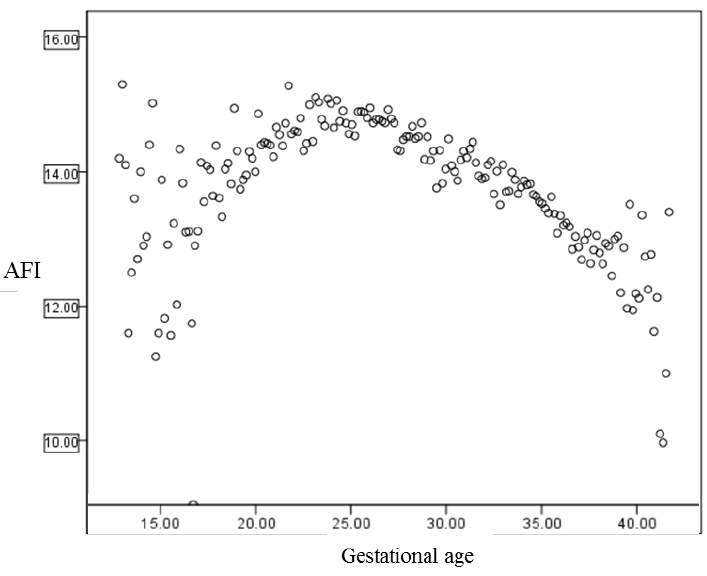
Figure 2. Average AFI throughout each gestational age.